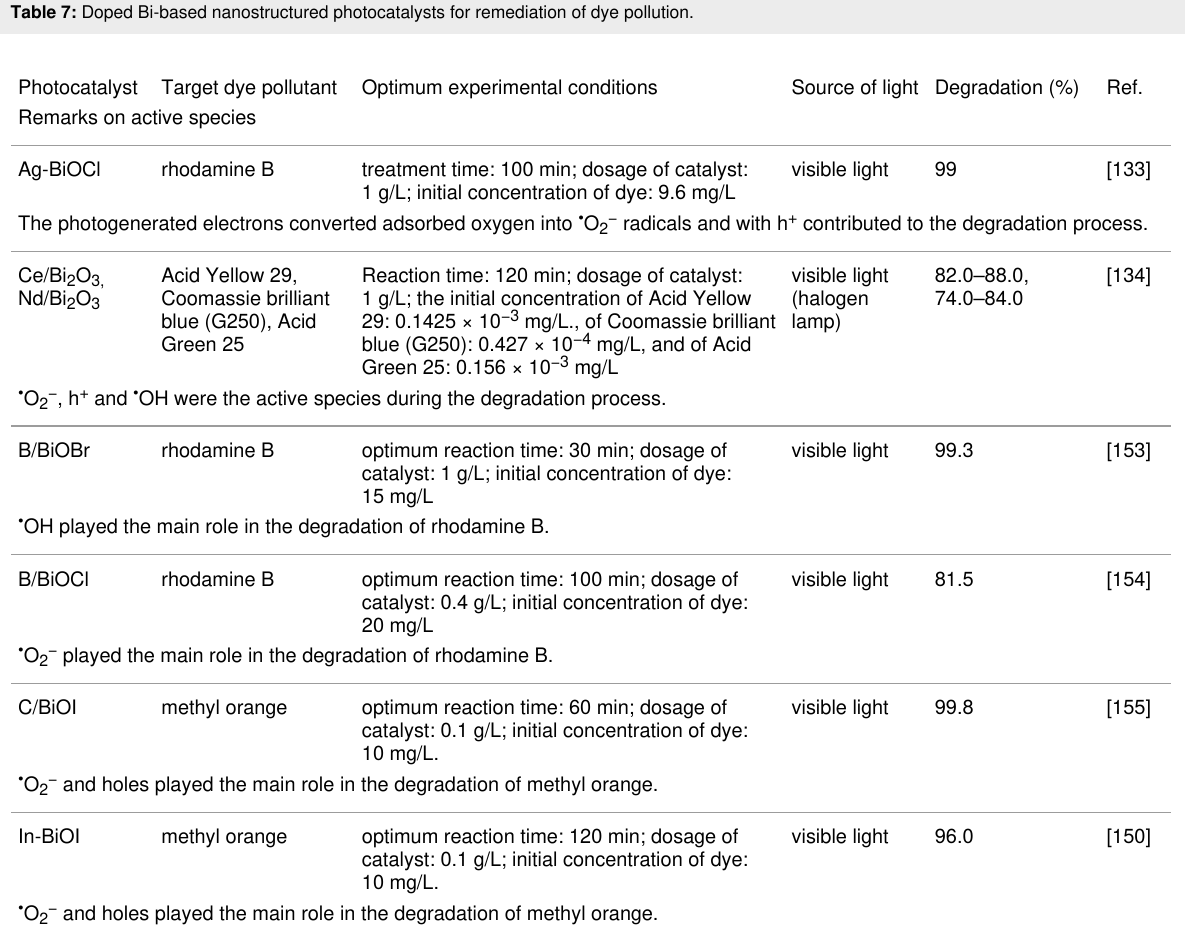
Table 7: Doped Bi-based nanostructured photocatalysts for remediation of dye pollution.